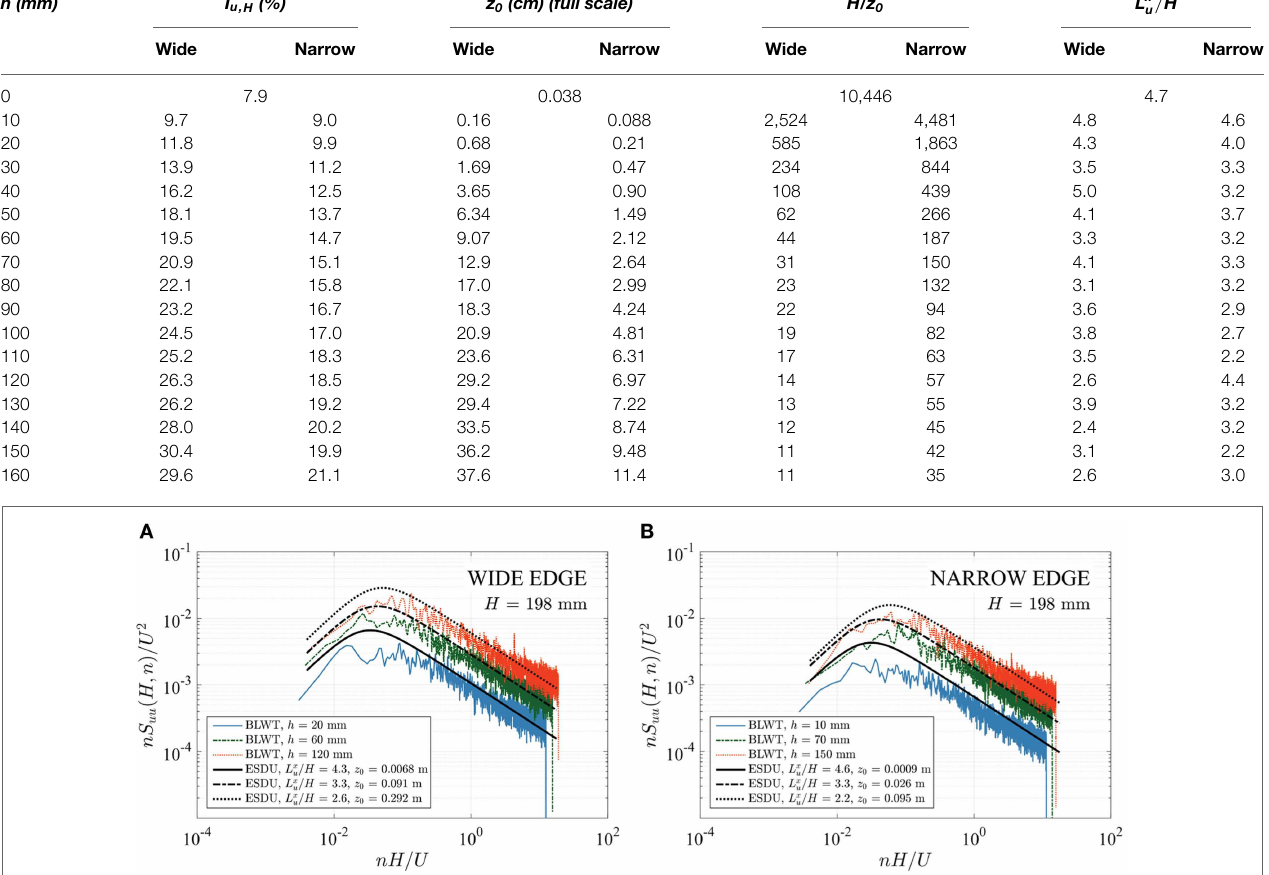
FIGURE 4 | Longitudinal turbulence spectra at a z = 19.8cm ( z = 3.96m full scale, 1:20 simulation) for a wide (A) and narrow (B) edge element orientations.